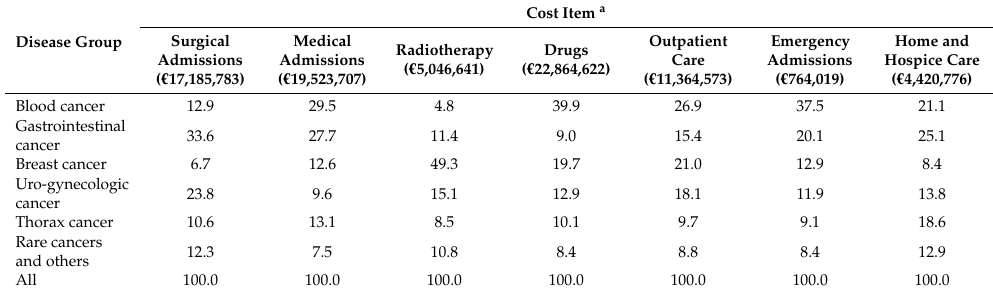
Table 3. Percent distribution of the total annual cost of each cost item for cancer care by disease group (Province of Forl ì -Cesena, northern Italy, year 2016). Disease